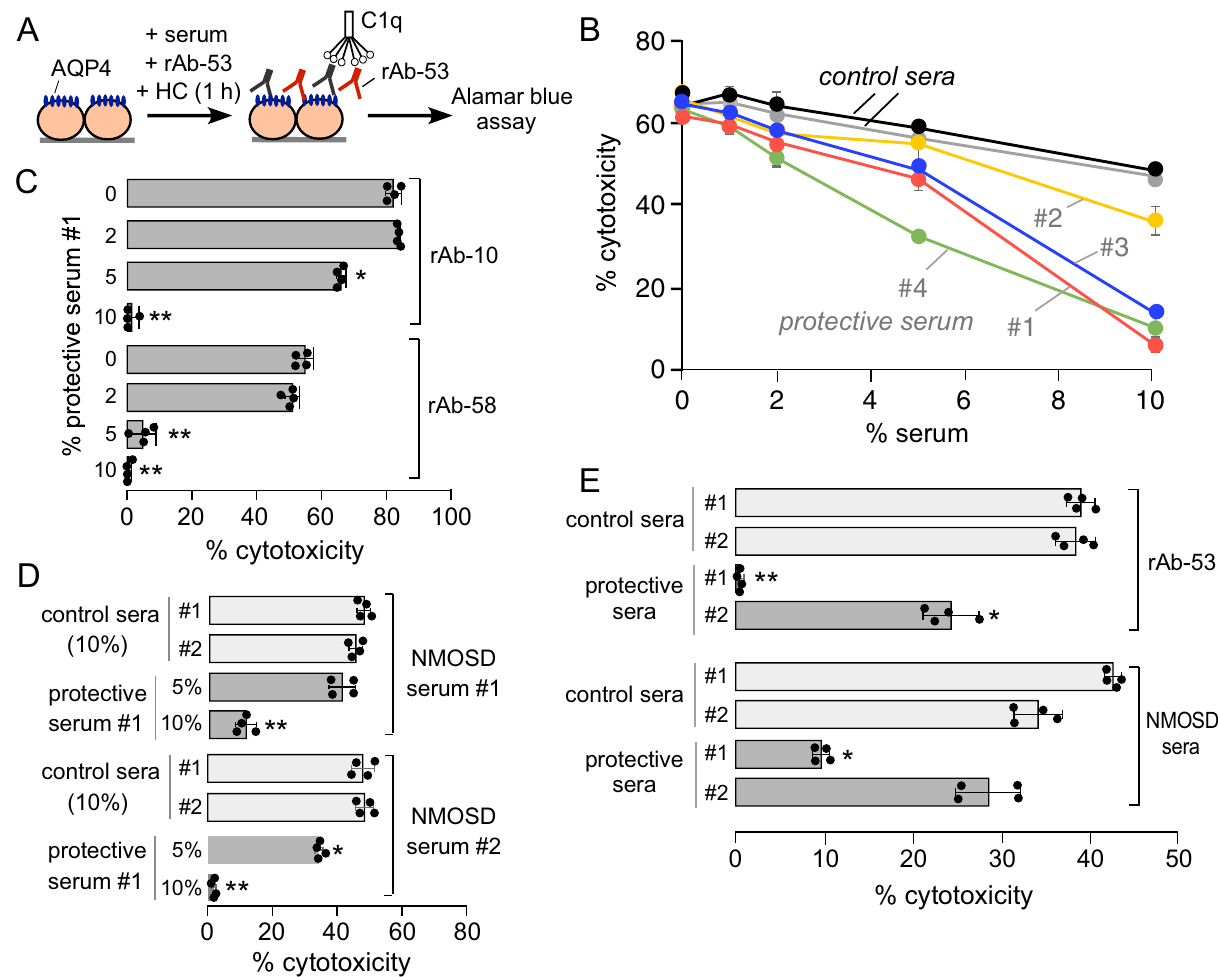
Figure 2. Cytoprotection in a CDC assay conferred by a subset of AQP4-IgG seropositive NMOSD patient sera. ( A ) Cytoprotection assay in which CDC was measured by Alamar blue assay after incubation of AQP4- expressing cells with human complement (HC) and a mixture of cytotoxic AQP4-IgG (such as rAb-53) and heat-inactivated test serum. ( B ) CDC in AQP4-expressing CHO cells as a function of percentage of test NMOSD serum. CDC was produced by 0.5 μg/ml rAb-53 as cytotoxic AQP4-IgG (mean ± S.E.M., n = 4). Data shown for two control sera and four NMOSD patient sera that produced significant cytoprotection. ( C ) CDC measured as in B, but with cytotoxicity produced by monoclonal AQP4-IgGs rAb-10 or rAb-58 (each 5 μg/ ml) (mean ± S.D., n = 4, * P < 0.05 vs. 0% protective serum by nonparametric Mann–Whitney test). ( D ) CDC measured as in B, with cytotoxicity produced by two NMOSD patient sera (mean ± S.D., n = 4, * P < 0.05, ** P < 0.01 vs. control sera by Kruskal–Wallis test with Dunn’s multiple comparison). E. CDC measured as in B, but with primary cultures of murine astrocytes in which cytotoxicity was produced by rAb-53 or NMOSD patient sera (mean ± S.D., n = 4, * P < 0.05 vs. control sera by Kruskal–Wallis test with Dunn’s multiple